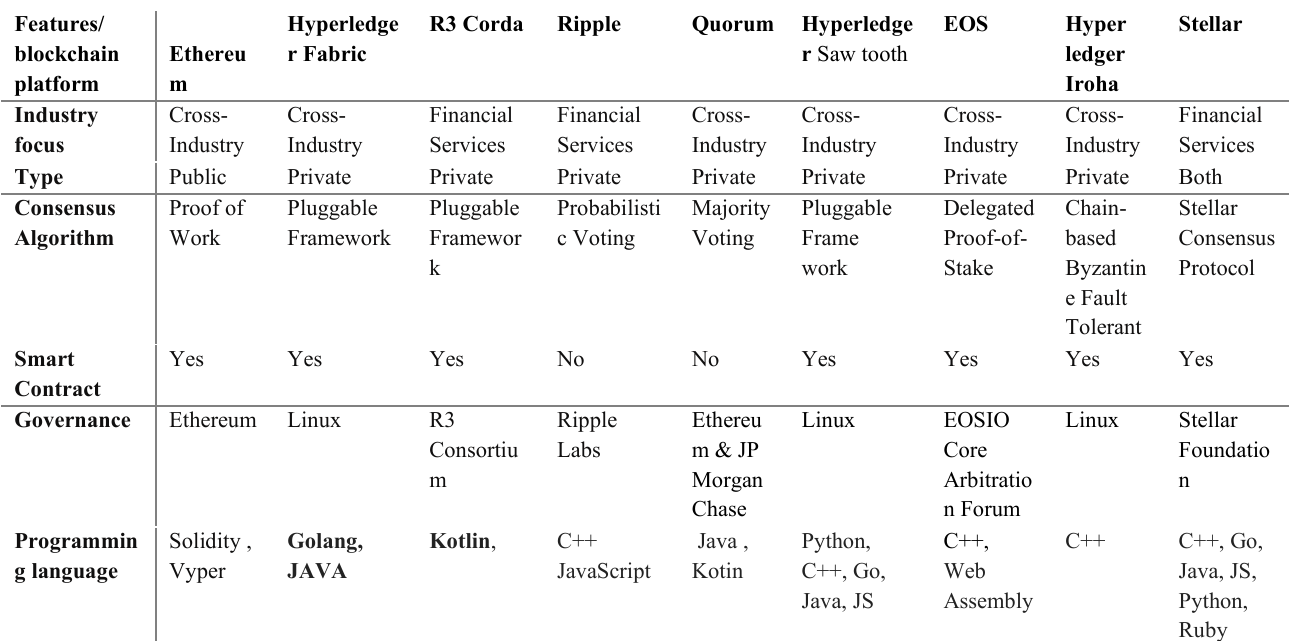
Table 3. Availability of Blockchain Technology platforms for various